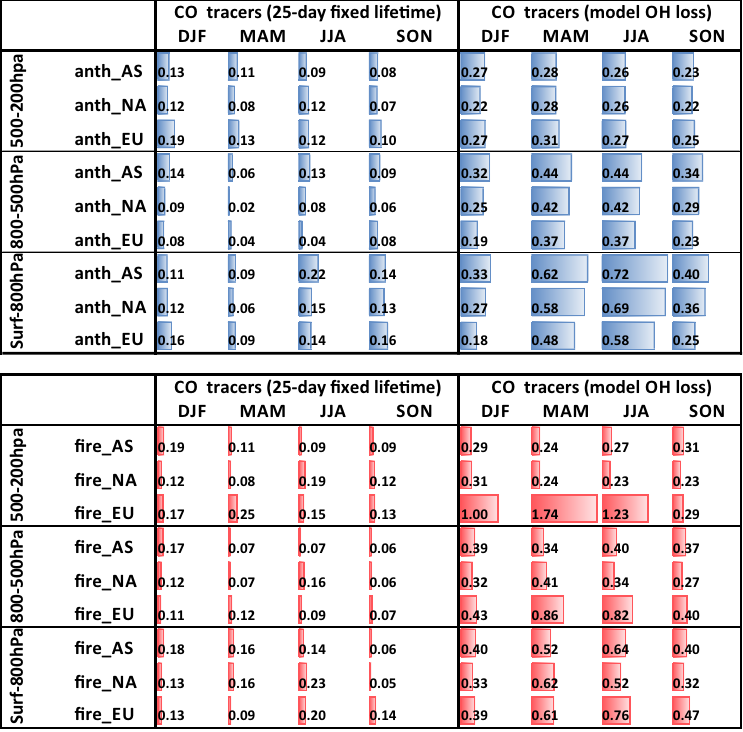
) calculated from the POLMIP model data binned into altitude bands at latitudes north of 66 ◦ N Figure 17. Coefficients of variations ( σ µ shown in Figs. 14 and 15. The size of the data bars represent the value of the coefficients with anthropogenic coefficients in blue and fire coefficients in